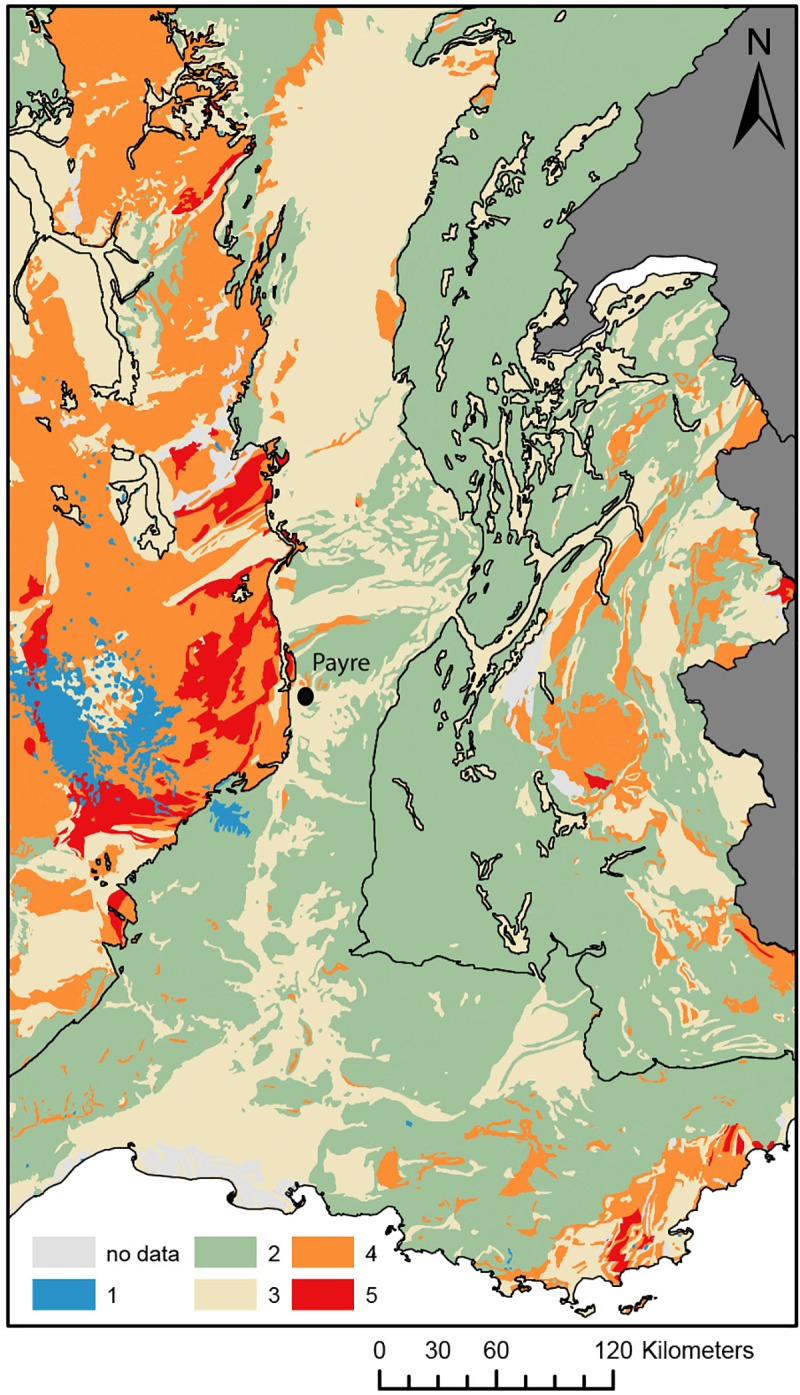
Strontium isotope groups based on the IRHUM database of 87Sr/86Sr isotope ratios of soil and plant samples for France [76].